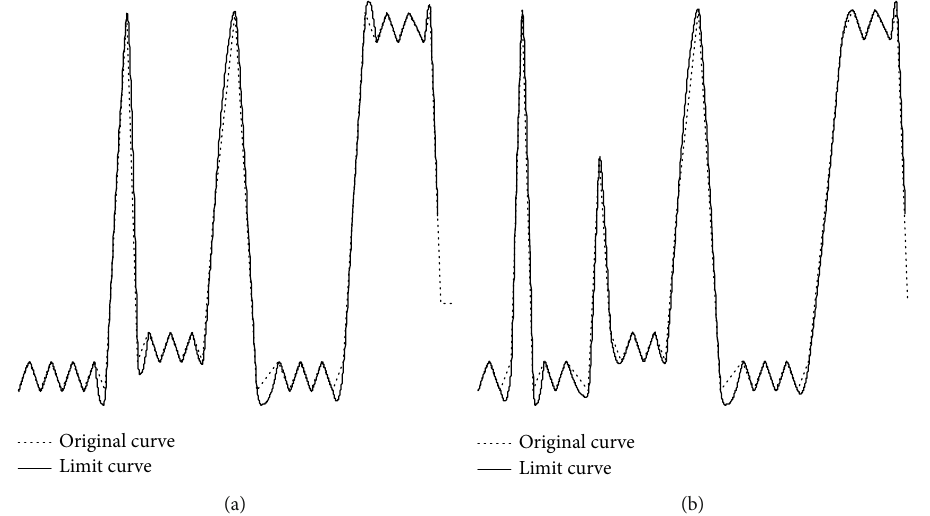
Figure 9: Application of R subdivision level.